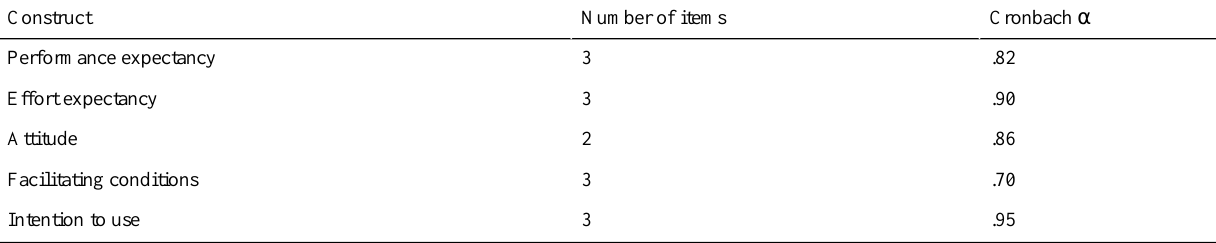
Table 4. Reliability